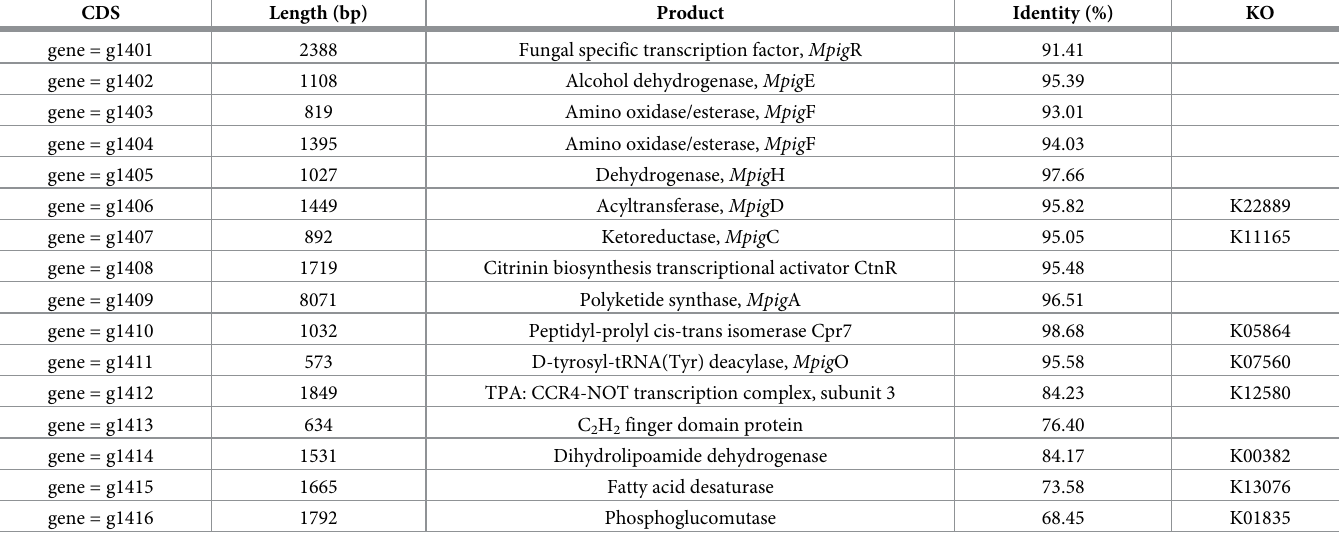
Table 4. Functional prediction of genes detected in the MPs BGC of M . purpureus